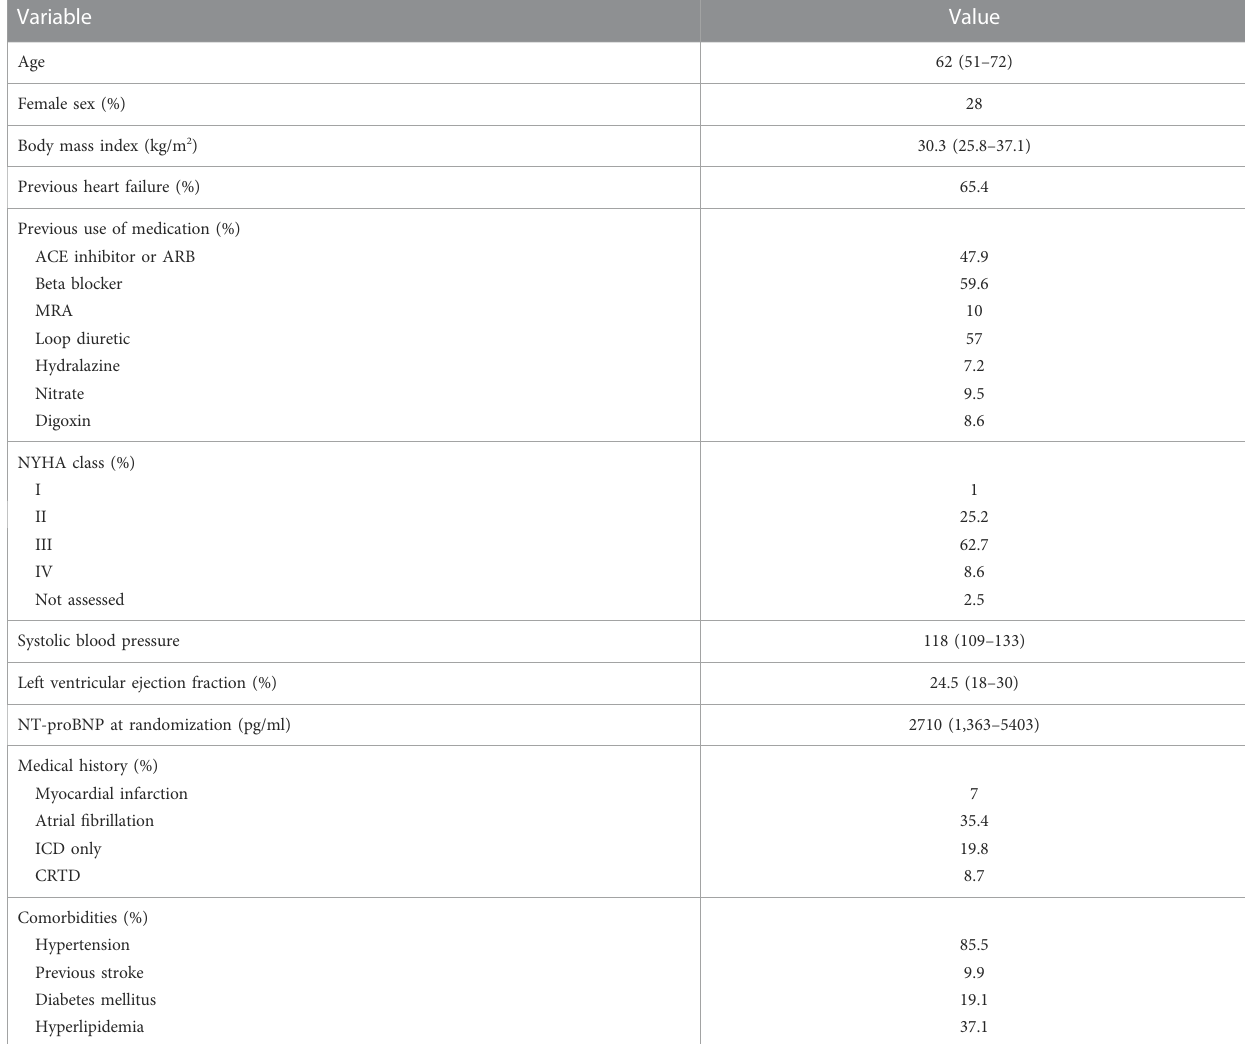
TABLE 1 Baseline characteristics of patients included in the PIONEER-HF